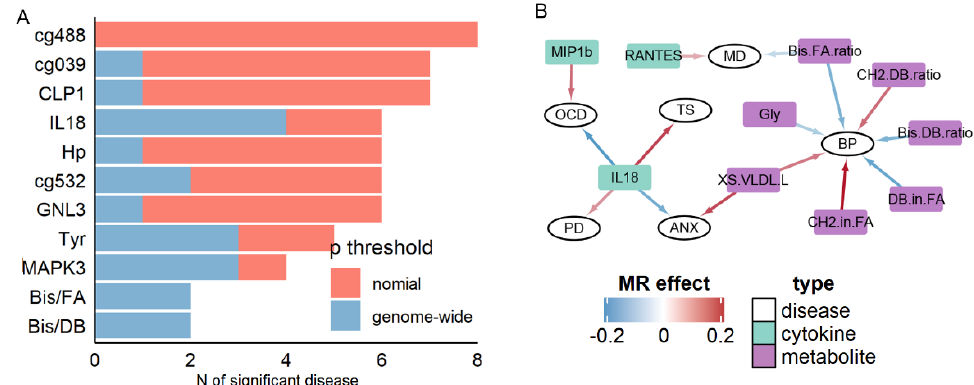
Figure 2. Summary of pleiotropic results. ( A ) Selected top molecules associated with multiple diseases. ( B ) Association between cytokines, metabolites, and diseases.